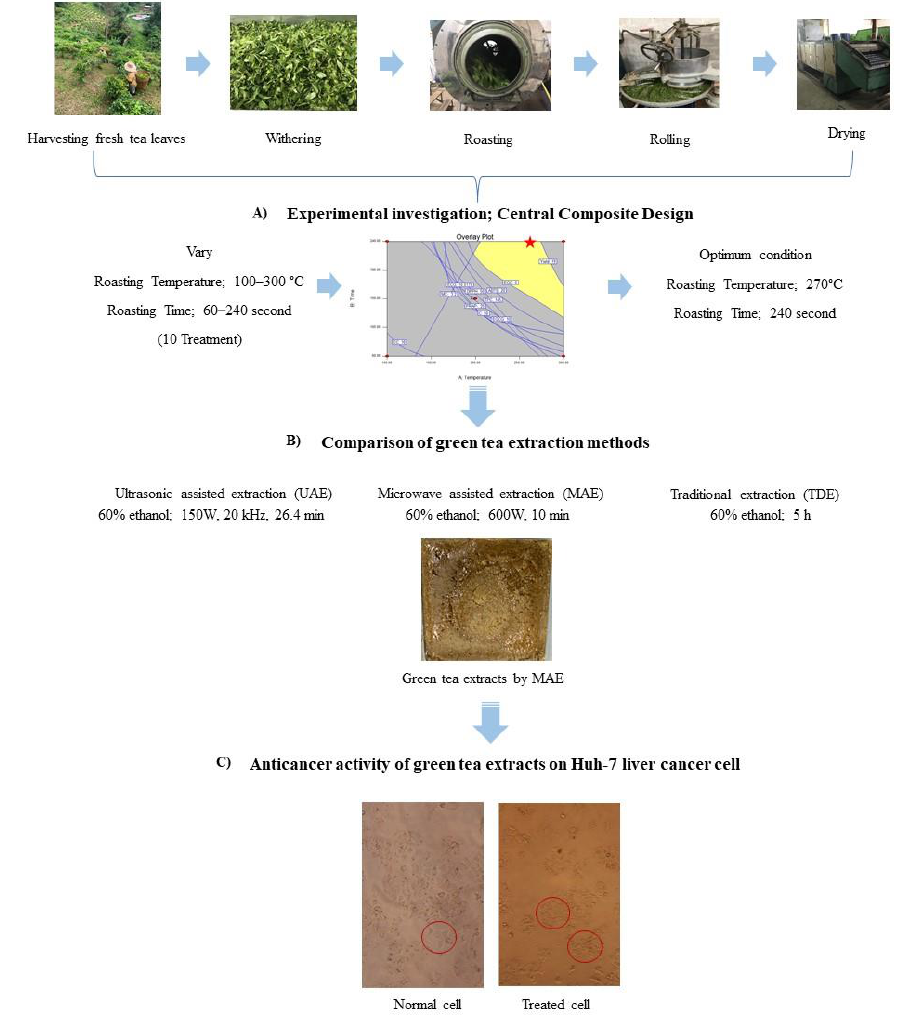
Figure 1. Research methodology of green tea production using CCD experiment with varying roasting temperatures and roasting times. ( A ) Fresh green tea leaves were harvested, withered, roasted, rolled and dried. ( B ) Comparison of green tea extraction methods by UAE, MAE, TDE. ( C ) Direct microscopic observations of Huh7 cells treated with green tea extracts at 125 µg/mL under microscope with 10× magnification compared to untreated control.